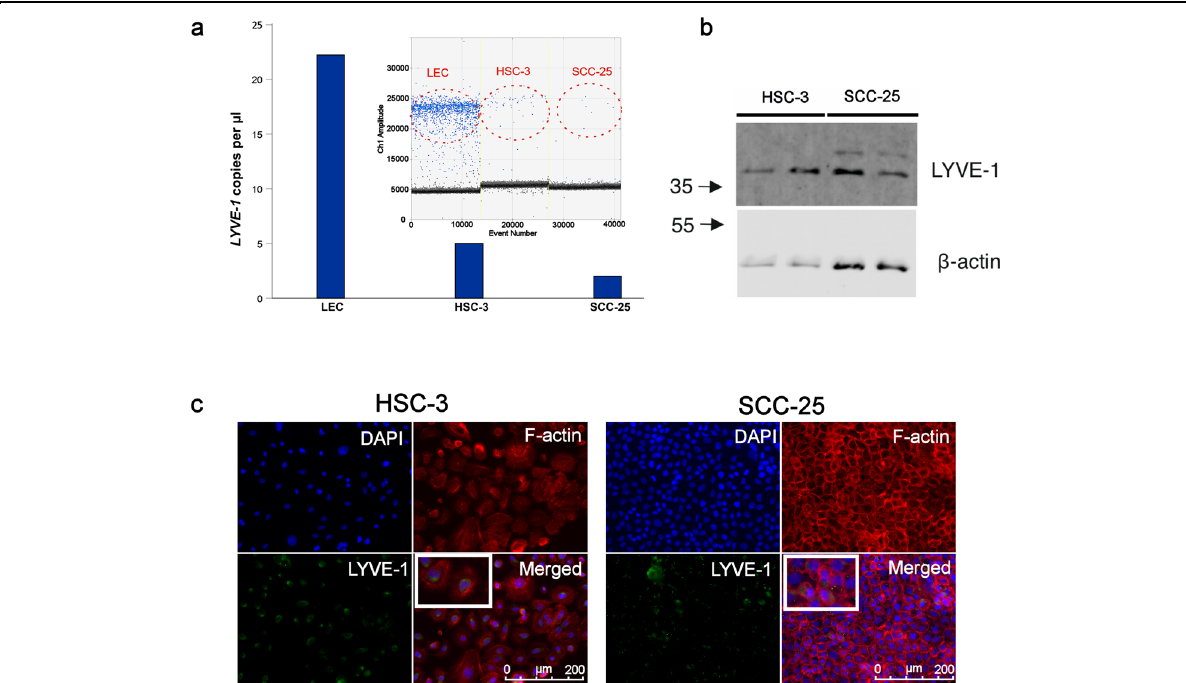
Fig. 2 OSCC cell lines express the lymphatic endothelium-speci fi c LYVE-1. a Droplet-digital PCR analysis revealed a positive expression of LYVE-1 in OSCC cell lines. The used cell lines are detailed in the supplementary materials. The ddPCR was performed as recently reported 48 . The LYVE-1 primers were designed using the Primer-BLAST tool (powered by Primer3) in NCBI website. The primers were checked by BLAST analysis to avoid any non-speci fi c binding. The LYVE-1 primer sequences were as follows: forward 5 ′ -GTGAGCAAAAAGGCGAACC-3 ′ ; reverse 5 ′ -AATCCATCTCCAACCCAGC- 3 ′ . Detection of positive droplets and data analysis were performed using QX200 ™ Droplet Digital ™ PCR Systems (Bio-Rad Laboratories) and QuantaSoft software (version 1.7.4.0917; Bio-Rad Laboratories) according to the manufacturer ’ s instructions. b The LYVE-1 protein was also detected in both OSCC cell lines by immunoblotting. The immunoblotting details can be found in the supplementary materials. c Double IF staining revealed positive LYVE-1 immunoreactivity in both OSCC cell lines. HSC-3 and SCC-25 cells were cultured on coverslips, washed in PBS and fi xed using 4% paraformaldehyde. Cells were then stained with the same LYVE-1 antibody as above, and incubated with Alexa Fluor ™ -568 Phalloidin for fi lamentous actin (F-actin; 1:200; Thermo Fisher Scienti fi c) for 30 min at RT. Next, cells were stained with DAPI (1:2000) and mounted with ProLong ® Gold Antifade Mountant (Thermo Fisher Scienti fi c). Scale bar 200